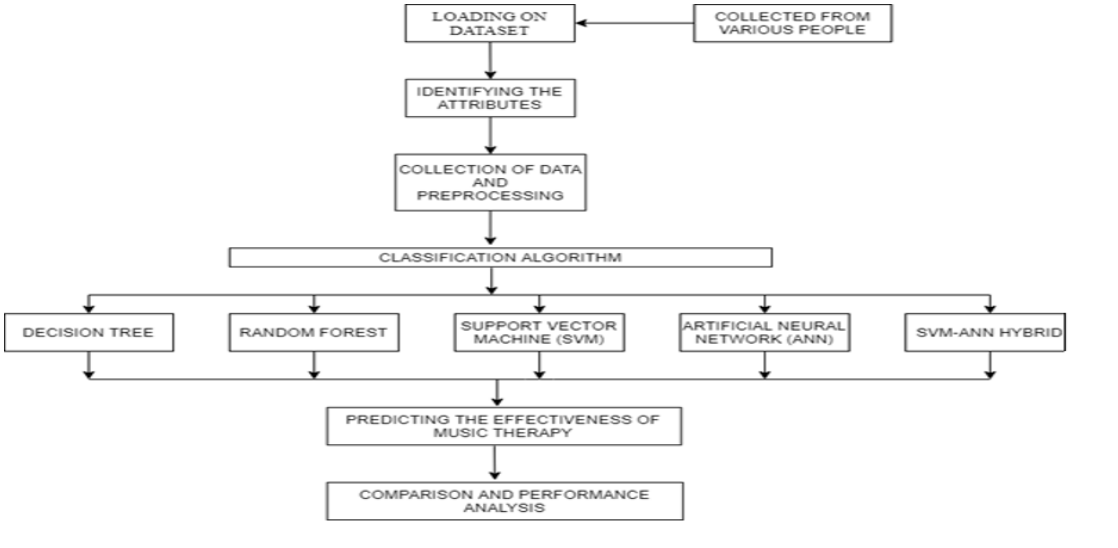
Figure 1. Proposed